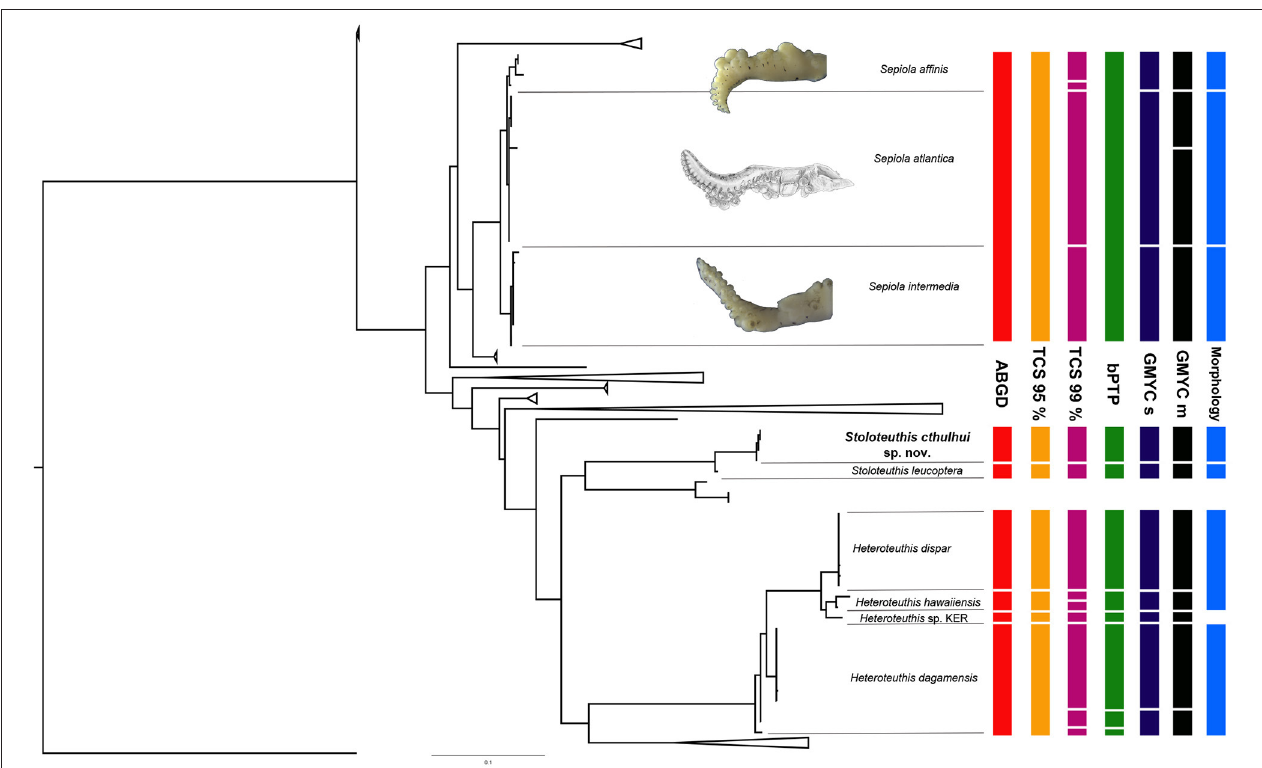
FIGURE 3 | Selected clades of the Maximum Likelihood tree depicted in Figure 2 . A summary of the species delimitation based on molecular methods (ABGD, TCS 95%, TCS 99%, bPTP, GMYC single threshold, and GMYC multi-threshold, the last two abbreviated as GMYC s and GMYC m, respectively) and morphology is provided at the right of the phylogenetic tree. Morphological diferences for the depicted species of the genus Sepiola is based in our material and de Heij and Goud (2010); for Stoloteuthis cthulhui sp. nov. and Stoloteuthis leucoptera based on the results of this study; and for Heteroteuthis spp. based on Vecchione and Young (2007), Judkins et al. (2016), and Braid and Bolstad (2019). Sepiola atlantica hectocotylus reproduced with permission from de Heij and Goud